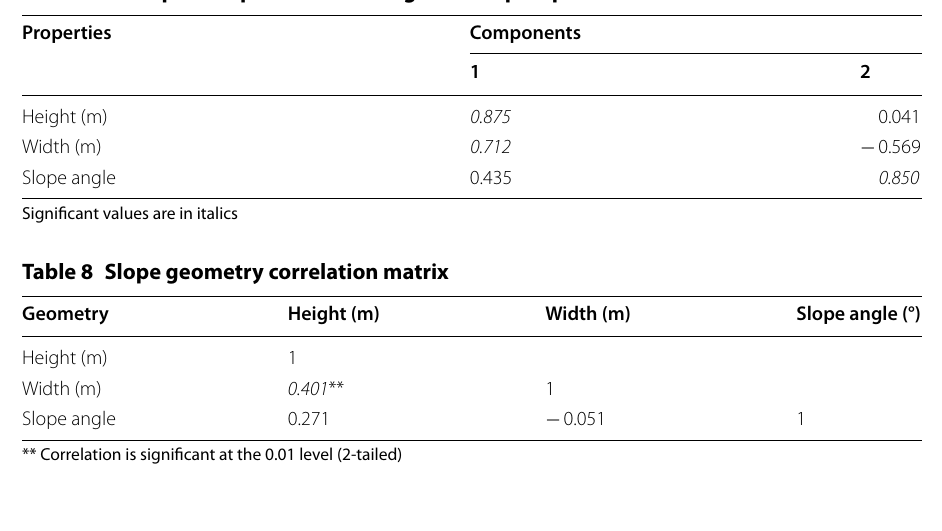
Table 7 Principal components affecting the dump slopes